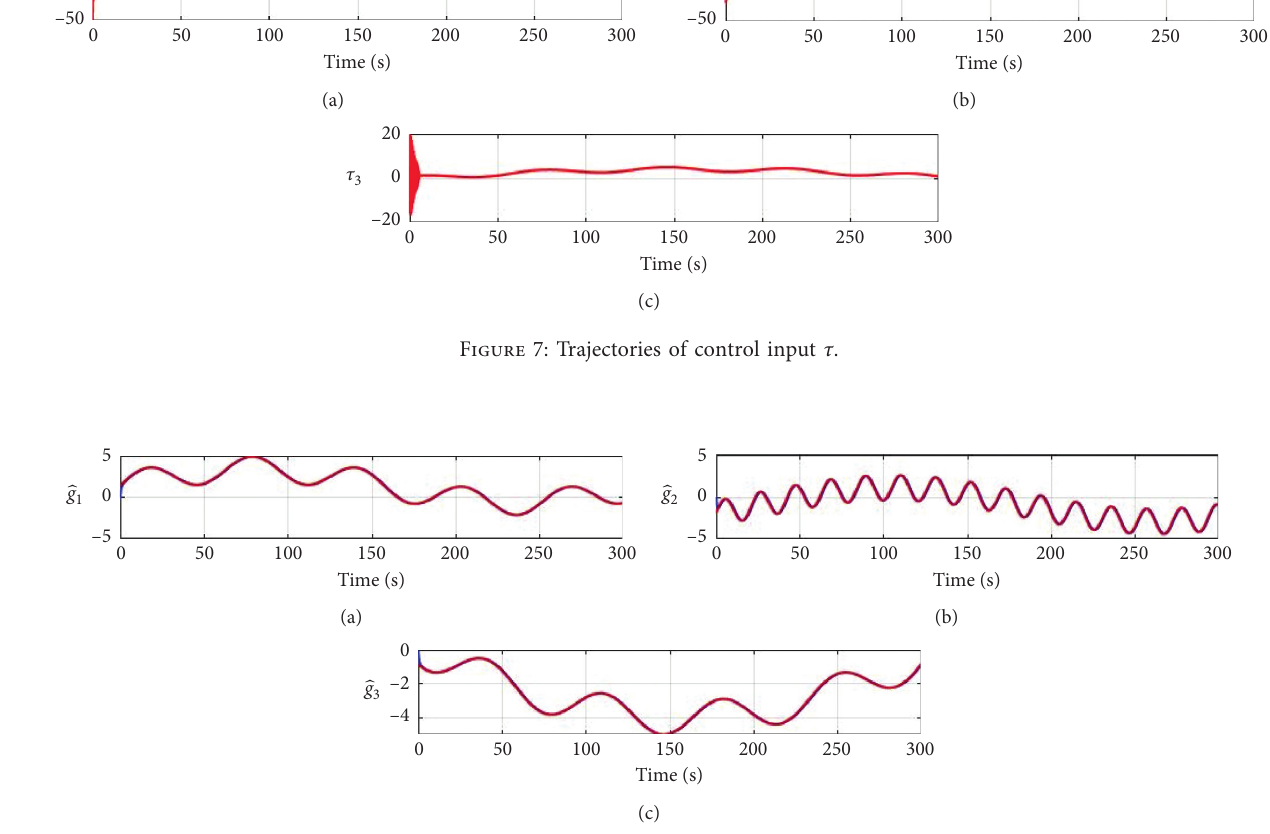
Figure 8: Trajectories of external disturbances g